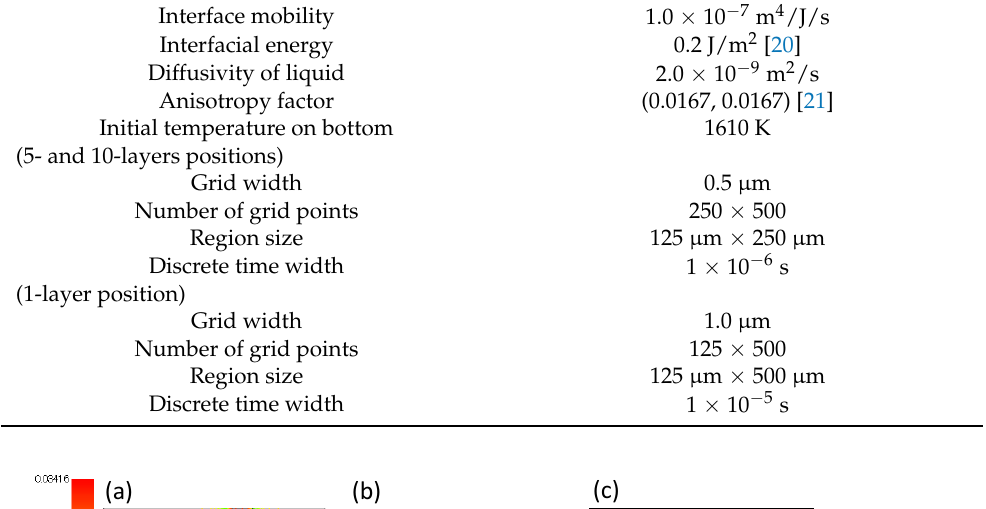
Table 5. Conditions of MPFM calculations for the 1-, 5-, and 10-layer positions.